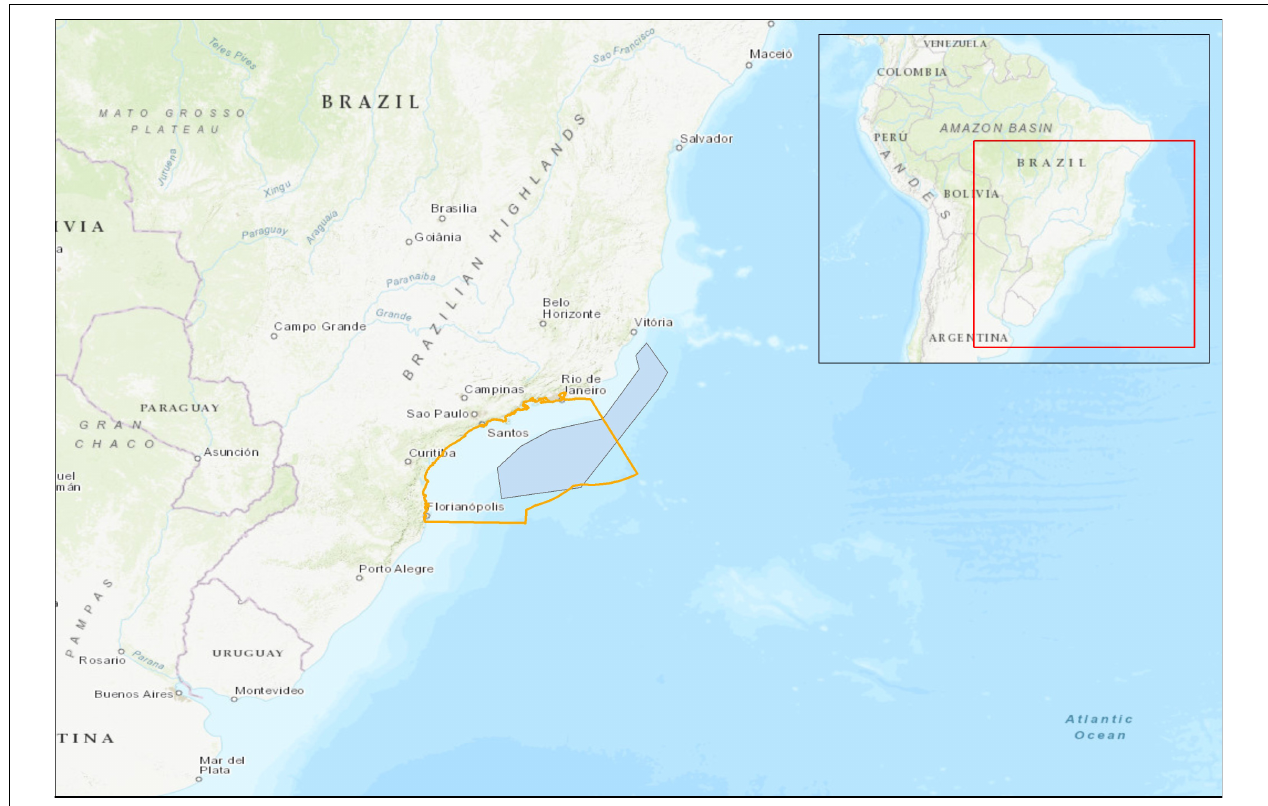
FIGURE 6 | Santos Basin region (red line) and the pre-salt